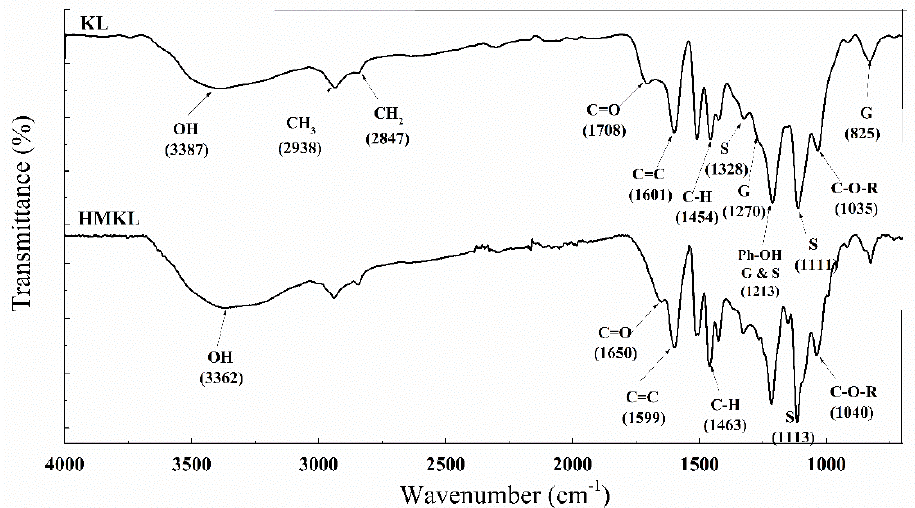
Figure 2. The Fourier transform infrared (FTIR) spectra of unmodified kraft lignin (KL) and hydroxymethylated kraft lignin (HMKL).